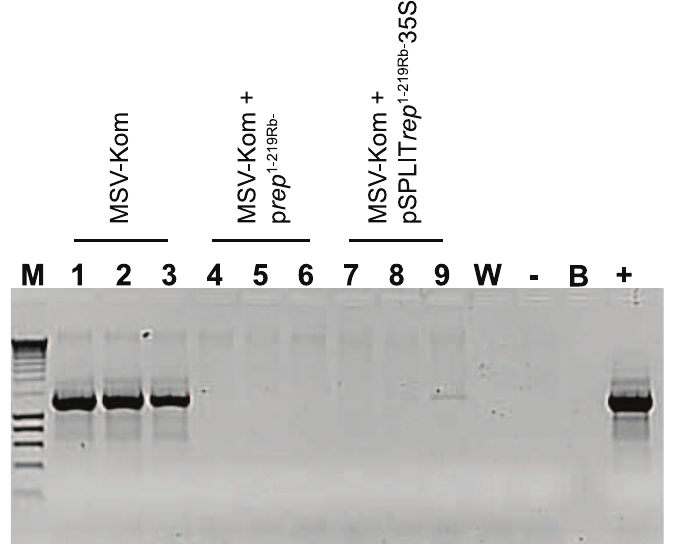
Figure 5. Replicative-form specific end-point PCR assay to test the effectiveness of the synthesised split gene cassette, pSPLIT rep 1-219Rb- 35S, in interfering with MSV replication. Black Mexican sweet (BMS) cells were bombarded with an infectious clone of MSV- Kom (pKom602) alone (lanes 1–3); pKom602 and pSPLIT rep 1-219Rb- 35S (lanes 7–9), as well as pKom602 and p rep 1-219Rb- (constitutively expressed from the maize ubiquitin promoter [16,17]) for comparative purposes (lanes 4–6). W=water control, 2 =non-bombarded BMS control, + = positive control (pKom602 plasmid DNA). B=blank. The PCR was performed on total DNA extracted from BMS cells four days post-bombardment.